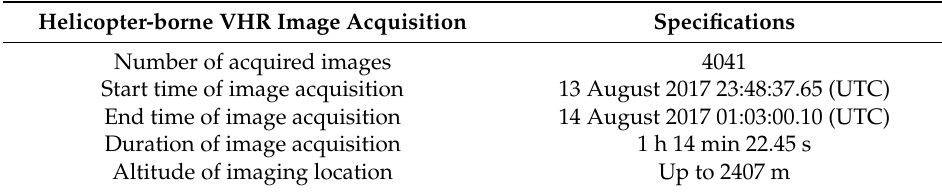
Table 3. Details of the helicopter-borne image acquisition